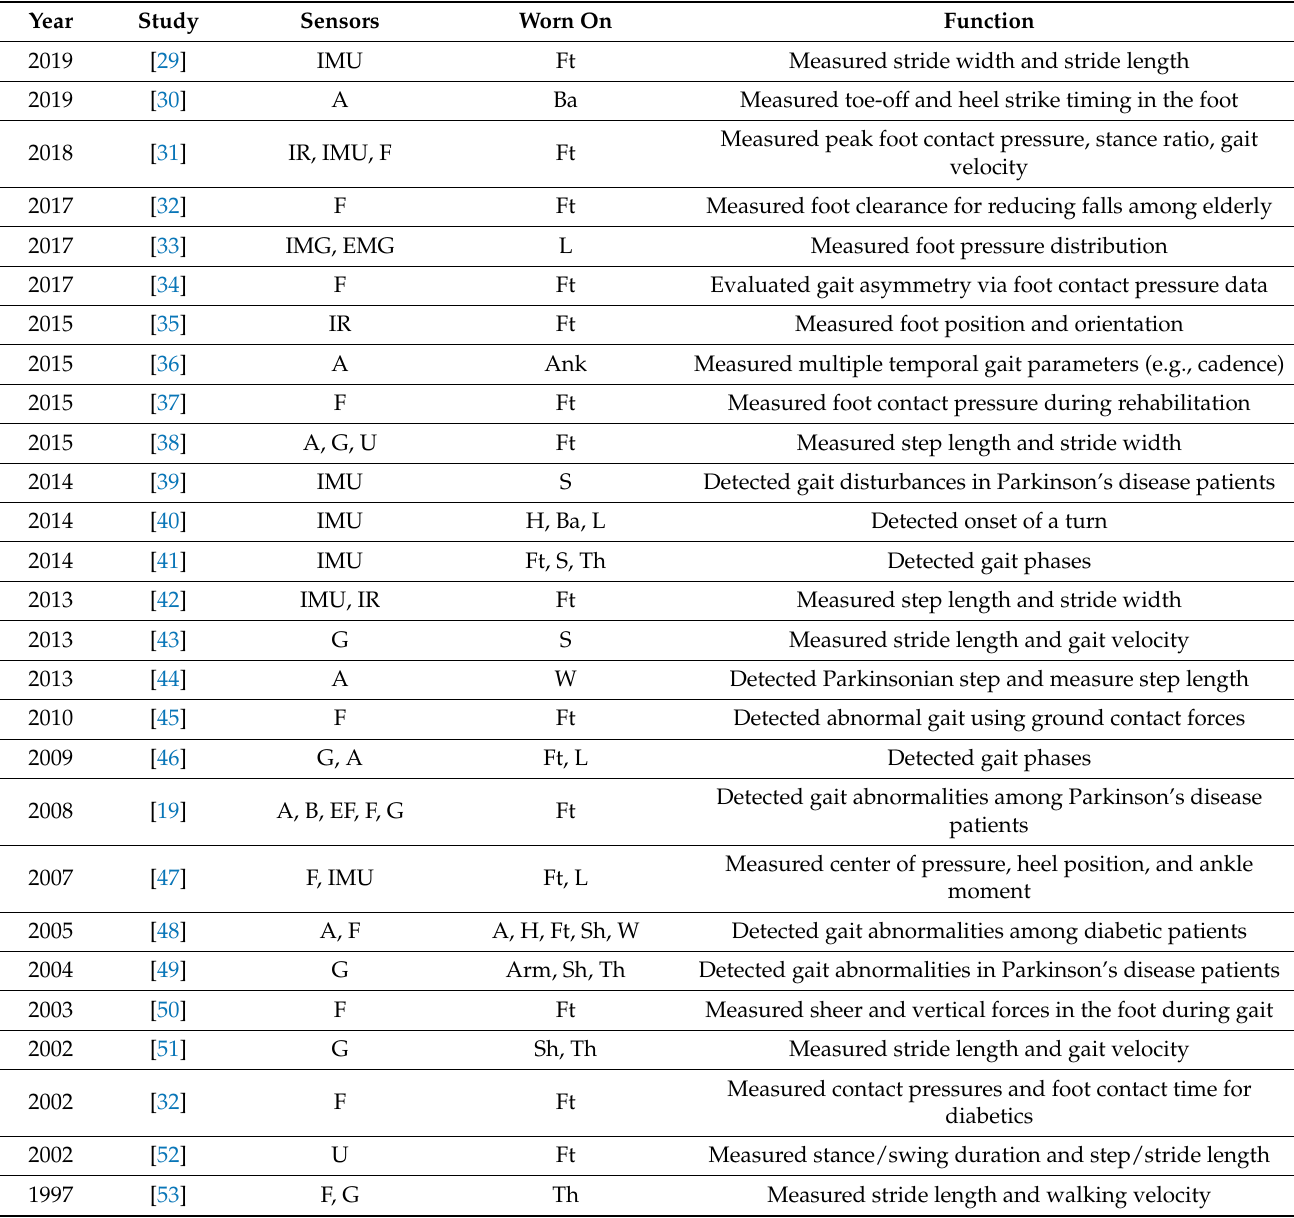
Table 1. Wearable Sensors Used for Gait